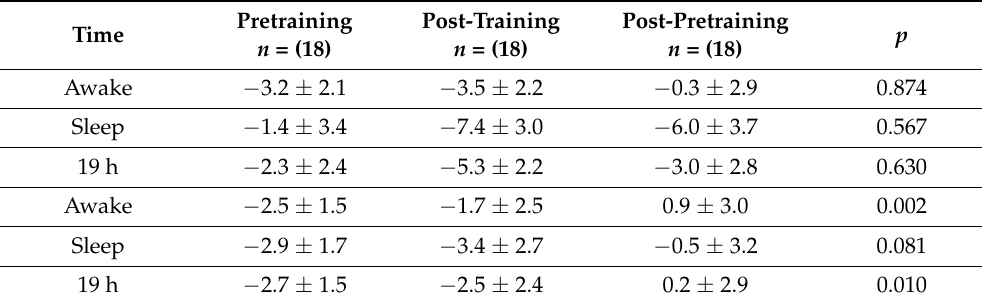
Table 2. Comparison of the ABP response to the GEST versus CONTROL after versus before training over awake, sleep, and 19 h (Mean ±